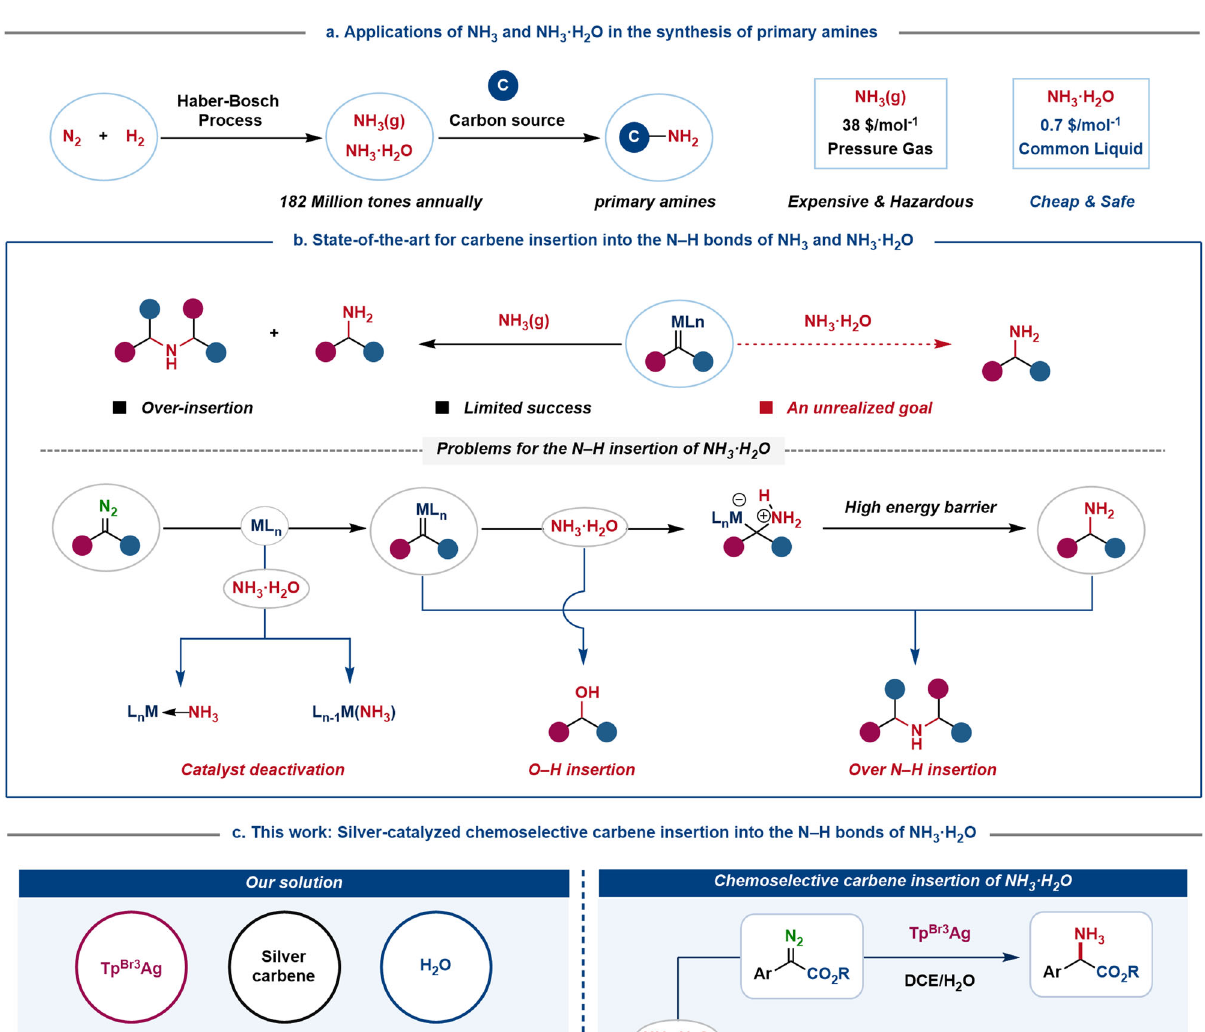
Fig. 1 | Direct route to primary amines from inorganic NH 3 and NH 3 ·H 2 O: strategiesandchallenges.a Strategiestoprimaryaminesusing NH 3 andNH 3 ·H 2 O as nitrogen source. b Challenges of N − H insertion of NH 3 ·H 2 O. c Tp Br3 Ag-catalyzed